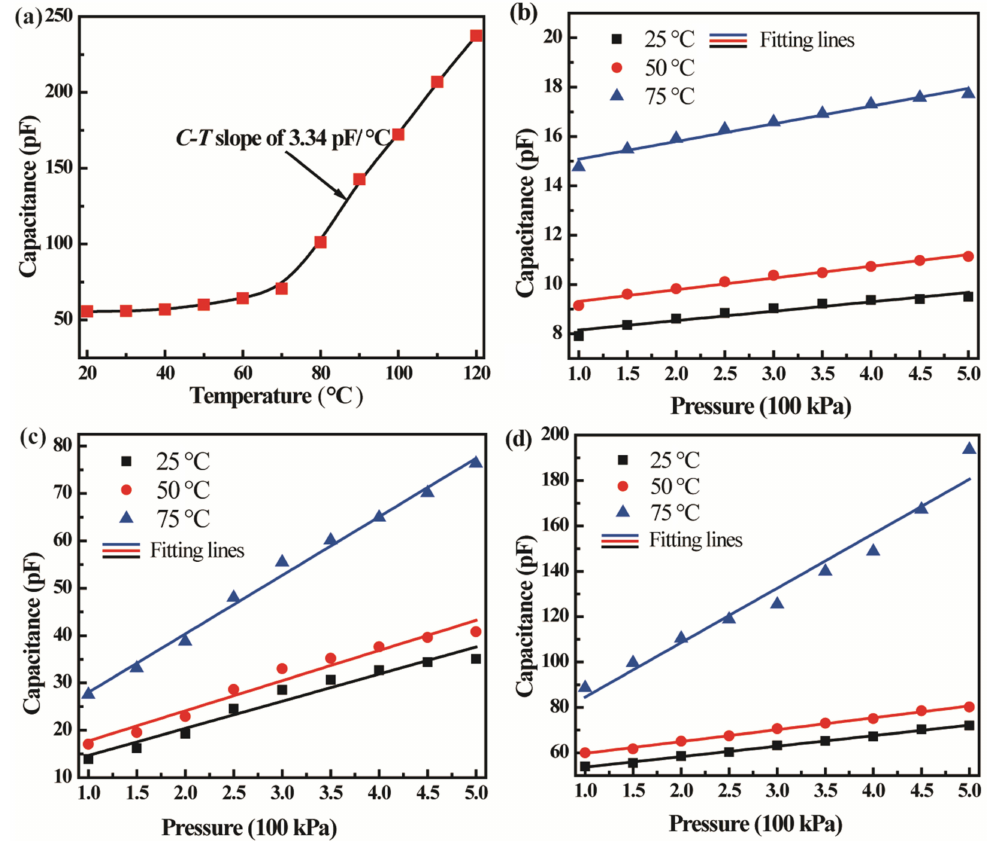
Figure 6. ( a ) C-T characteristic of CPS with diaphragm radius in 2000 µ m; C-P characteristics of CPSs with diaphragm radius of ( b ) 1000, ( c ) 1500, and ( d ) 2000 µ m at the ambient temperature of 25, 50, and 75 ◦ C,